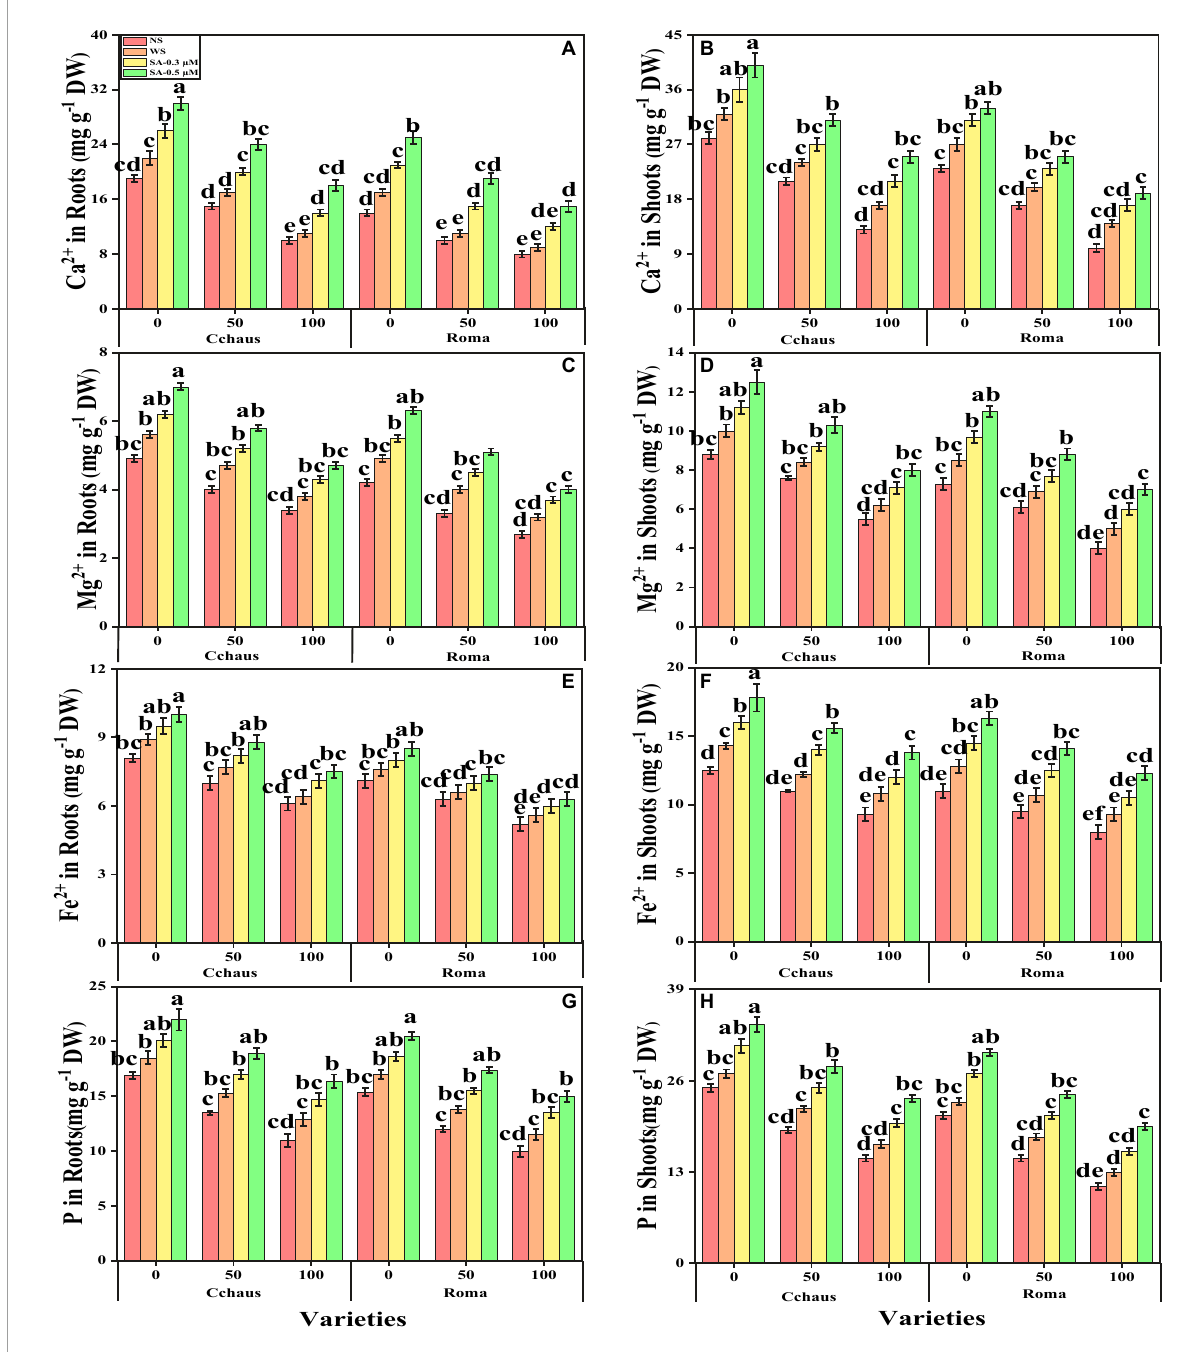
FIGURE6 Effect of exogenously applied syringic acid (0.3-0.5 ◦ µ M) on calcium contents in the roots (A) , calcium contents in the shoots (B) magnesium contents in the roots (C) , magnesium contents in the shoots (D) , iron contents in the roots (E) , iron contents in the shoots (F) , phosphorus contents in the roots (G) , and phosphorus contents in the shoots (H) on Solanum lycopersicum varieties (Cchaus and Roma) cultivated under stress levels of Pb [0 (no Pb), 50 and 100 mg kg − 1 ]. Values are demonstrated as means of four replicates along with standard deviation (SD; n = 4). Two-way ANOVA was performed and means differences were tested by HSD ( P < 0.05) through Tukey’s test. Different lowercase letters on the error bars indicate significant difference between the